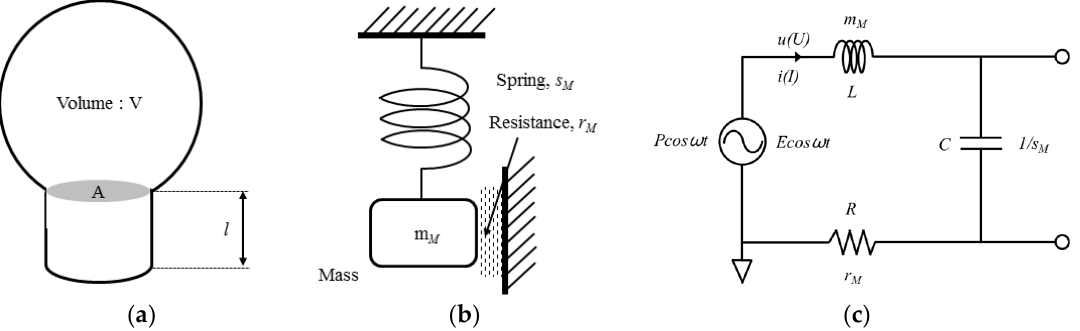
Figure 5. ( a ) Schematic of Helmholtz resonator, ( b ) mechanical model of Helmholtz resonator, and ( c ) equivalent circuit corresponding to the Helmholtz resonator.